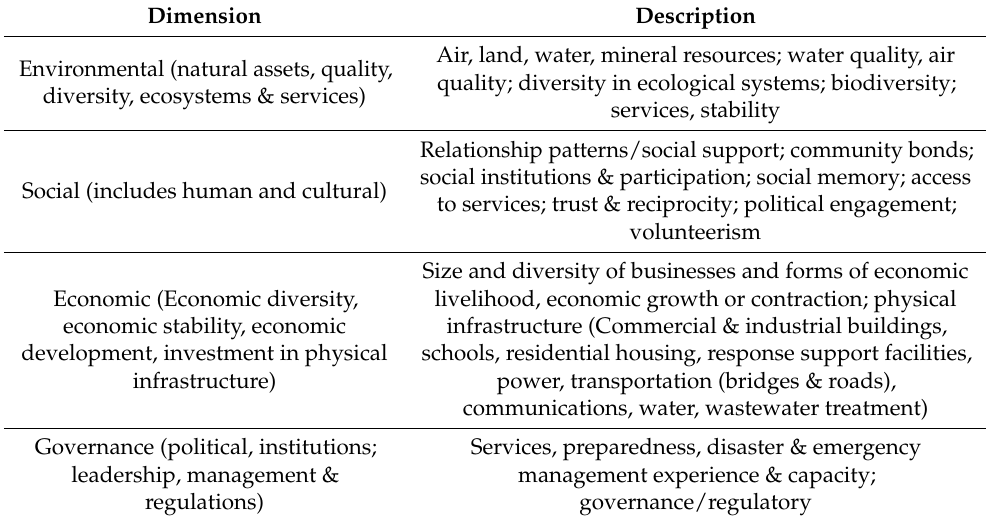
Table 1. Dimensions and characteristics of a resilient community. Dimension